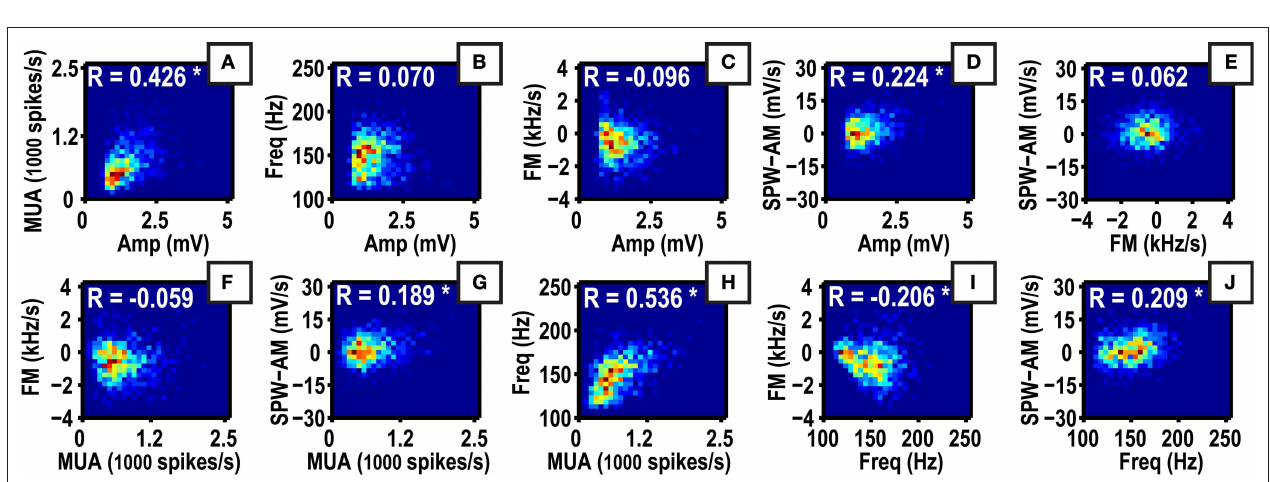
FIGURE 4 | Covariation of ripple features for Rat 1. (A–J) Two dimensional histograms represent the relationship between all combinations of ripple features shown in Figure 3 . These data are taken from Rat 1. The correlation coeffi cients for each feature combination are shown in white text (the asterisk denotes a correlation with p < 0.001). See Table 1 for a summary of feature correlations for all data